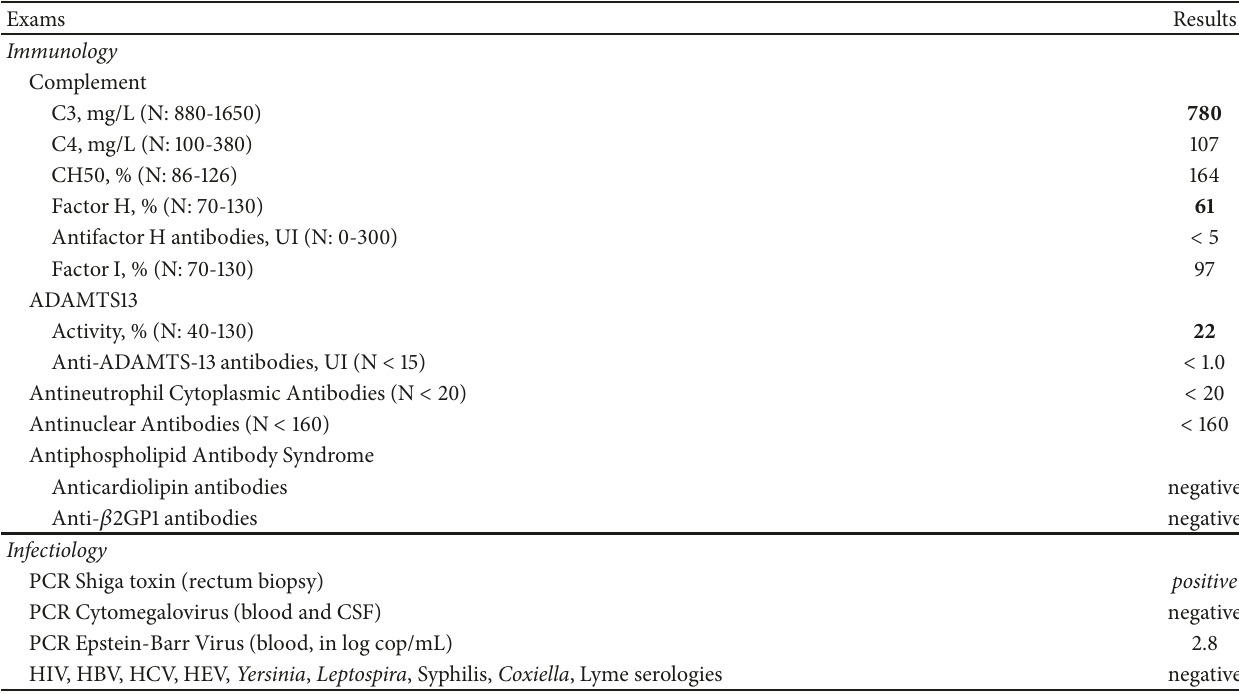
Table 1: TMA workup and